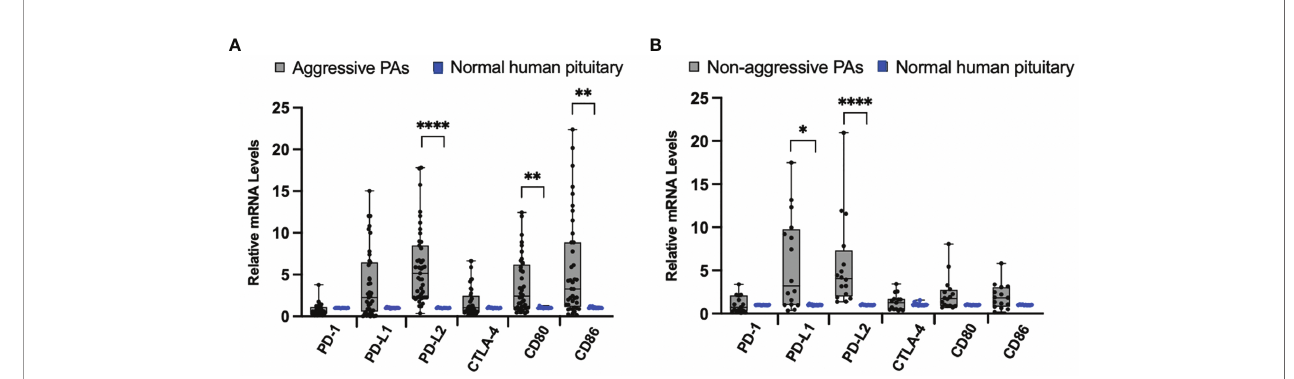
FIGURE 1 | Immune checkpoint molecule mRNA expression in pituitary adenomas (PAs) compared to normal human pituitary tissue. (A) Comparison of relative mRNA levels of immune checkpoint molecules between aggressive PAs (gray bar, black dots) and normal human pituitary tissue (blue dots). (B) Comparison of relative mRNA levels of immune checkpoint molecules in non-aggressive PAs (gray bar, black dots) and normal human pituitary tissue samples (blue dots). * p < 0.05; ** p < 0.01; **** p < 0.0001.